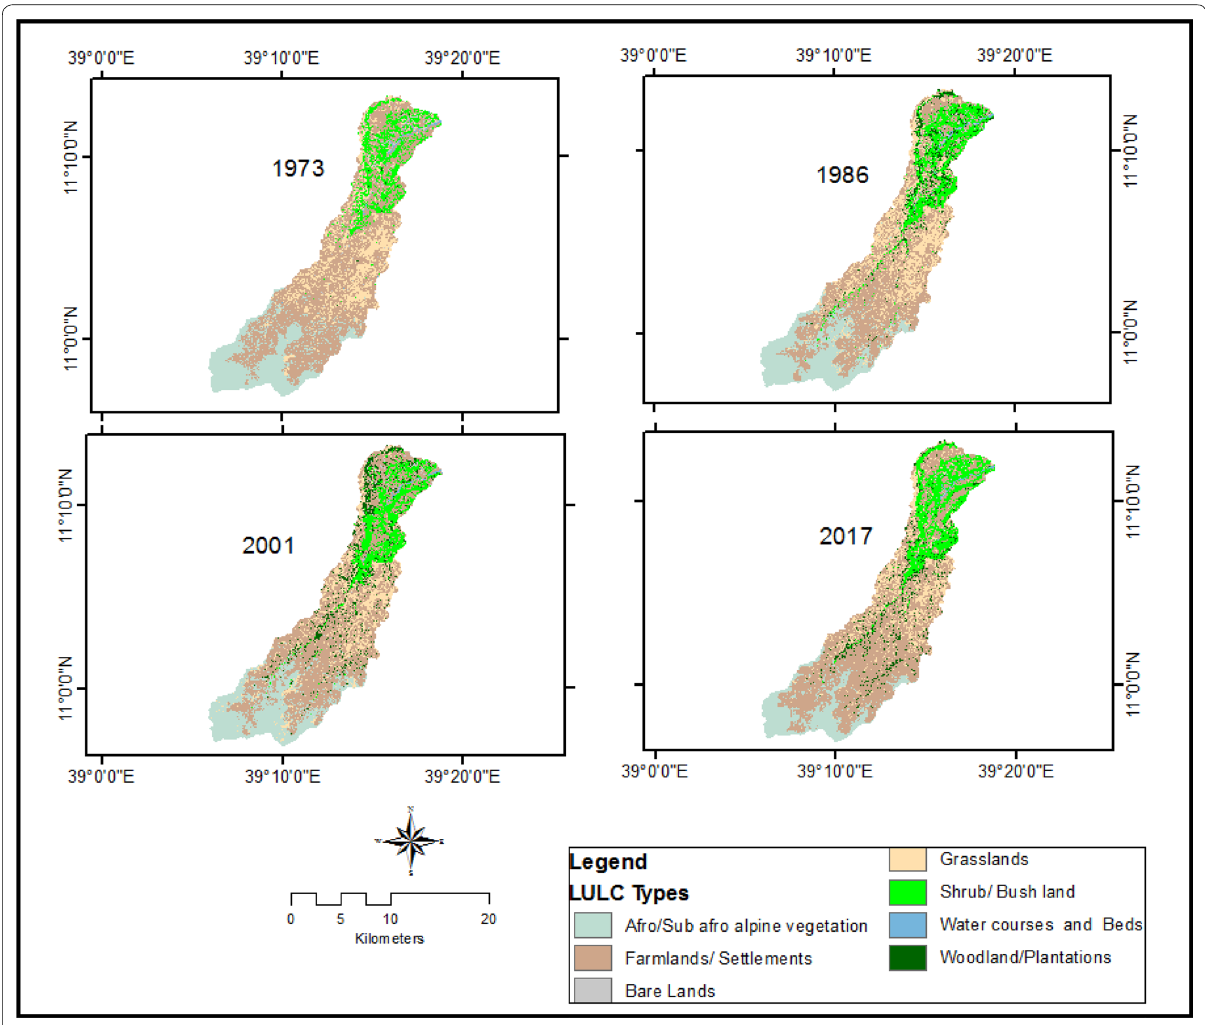
Fig. 7 Spatial patterns LULC of Gedals Watershed produced from satellite image, 2017